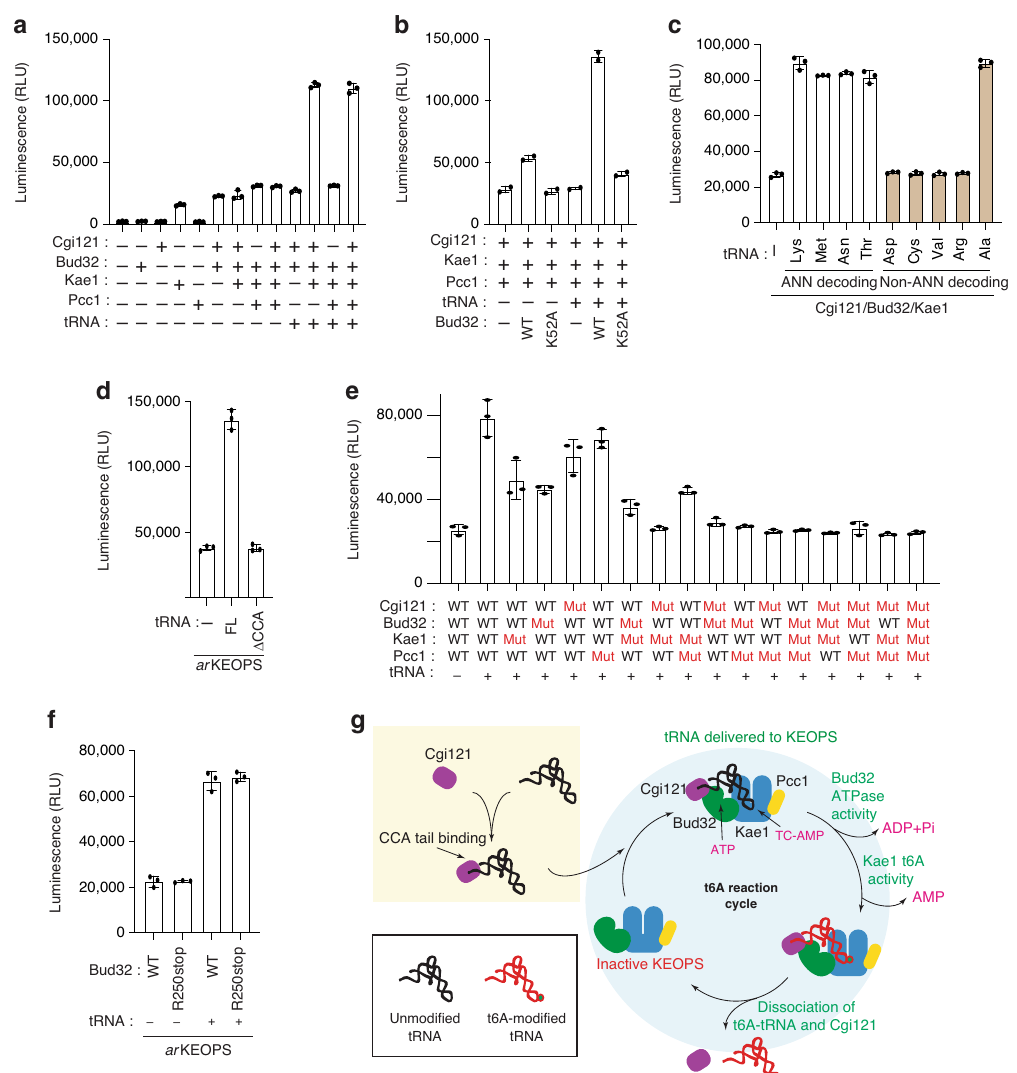
Fig. 7 The ATPase activity of Bud32 is potentiated by tRNA binding. a – f ATPase activity analysis of the indicated archaea KEOPS proteins in the presence and absence of mj tRNA Lys UUU. Activity was monitored using the ADP Glo assay. Displayed results represent the average luminescence ( n = 3 independent experiment samples, ±SD) for each reaction condition. c In addition to mj tRNA Lys UUU , the effect the alternate KEOPS substrates mj tRNA Met CAU, mj tRNA Asn GUU , mj tRNA Thr GGU , and the KEOPS non-substrates mj tRNA Asp GUC , mj tRNA Cys GCA mj tRNA Val CAC, mj tRNA Arg GCG , and mj tRNA Ala GGC on ATPase activity were also examined. d In addition to wild-type mj tRNA Lys UUU , the effect of mj tRNA Lys UUU Δ CCA on ATPase activity was also examined. e The mutant KEOPS proteins denoted by Mut (in red) are mj Cgi121 Met60Glu , mj Bud32 Arg60Glu , mj Kae1 Arg163Asp and pf Pcc1 Arg63Asp . g A model for the KEOPS t 6 A catalytic cycle. Cgi121 can bind tRNA independent of other KEOPS subunits (yellow box). Binding of the Cgi121 – tRNA complex to the Bud32 – Kae1 – Pcc1 complex delivers the tRNA substrate to KEOPS (blue circle). Binding of tRNA to KEOPS (and minimally the Cg121 – Bud32 – Kae1 subcomplex) activates the ATPase activity of Bud32 which in turns activates the t 6 A modi fi cation activity of Kae1. Dissociation of Cgi121 and t 6 A-modi fi ed tRNA from KEOPS completes a catalytic